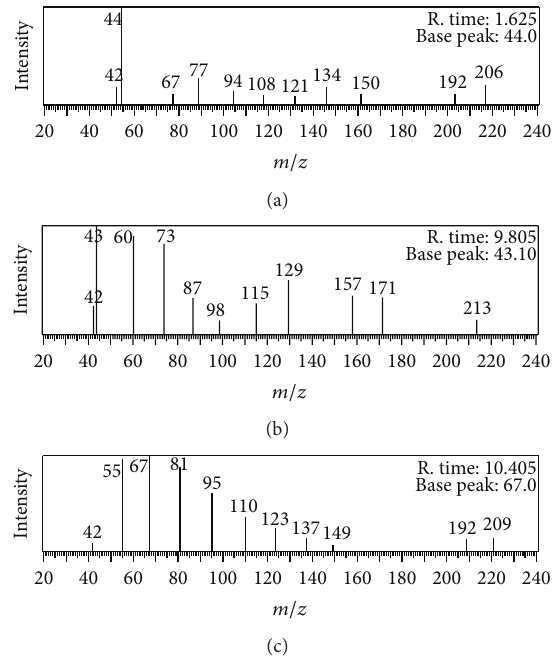
Figure 17: GC-MS chromatograms for degradation of 2,4,6-TNP by Al 2 O 3 ⋅ CaO nanocatalyst at retention time (a) 1.65min, (b) 9.805 min, and (c) 10.405